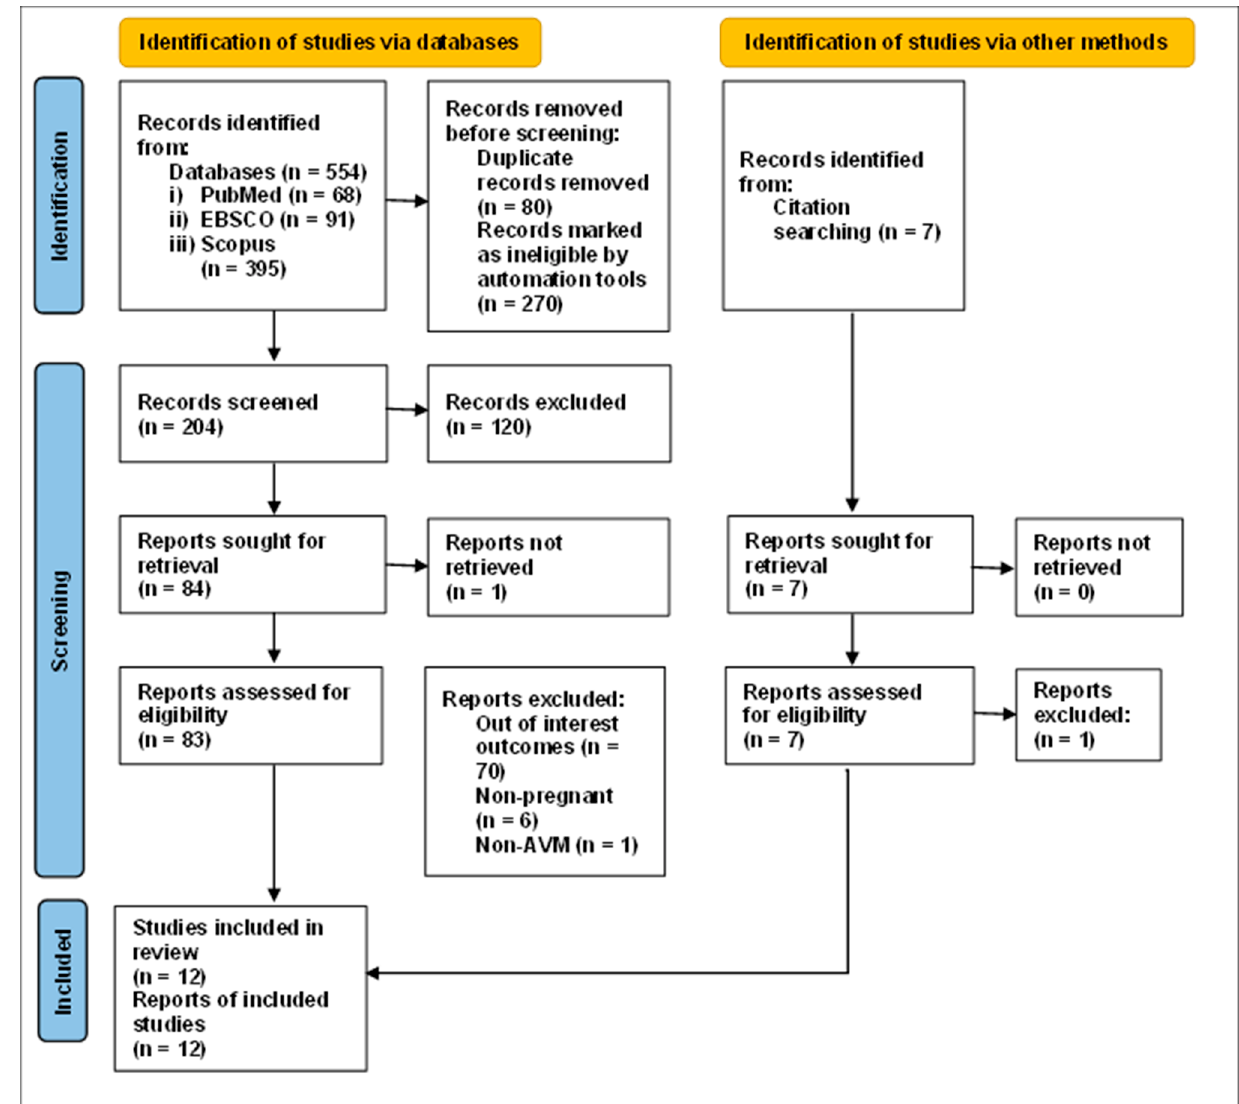
Figure 1. PRISMA 2020 flow chart.